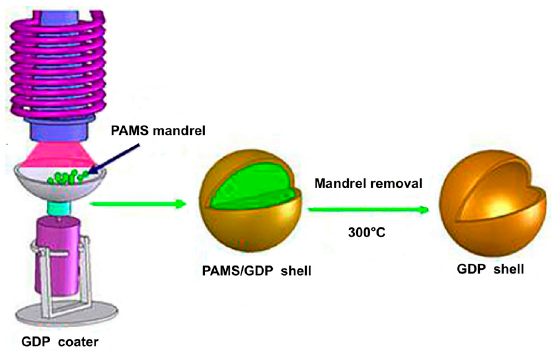
Figure 7. Schematic process for the fabrication of GDP shell. (GDP-glow discharge polymer; PAMS-poly α -methylstyrene). Reproduced with modifications from [122] under Creative Commons license.